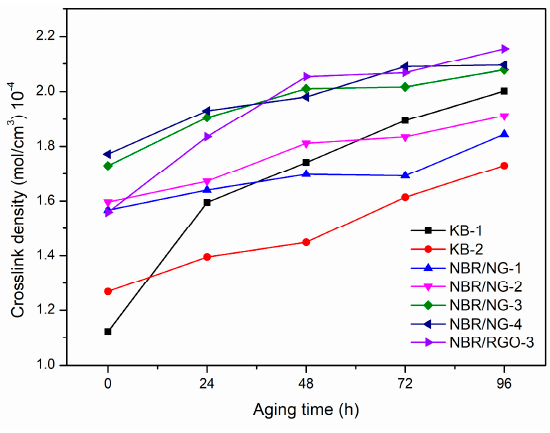
Figure 14. Cross-link density curves of NBR composites.